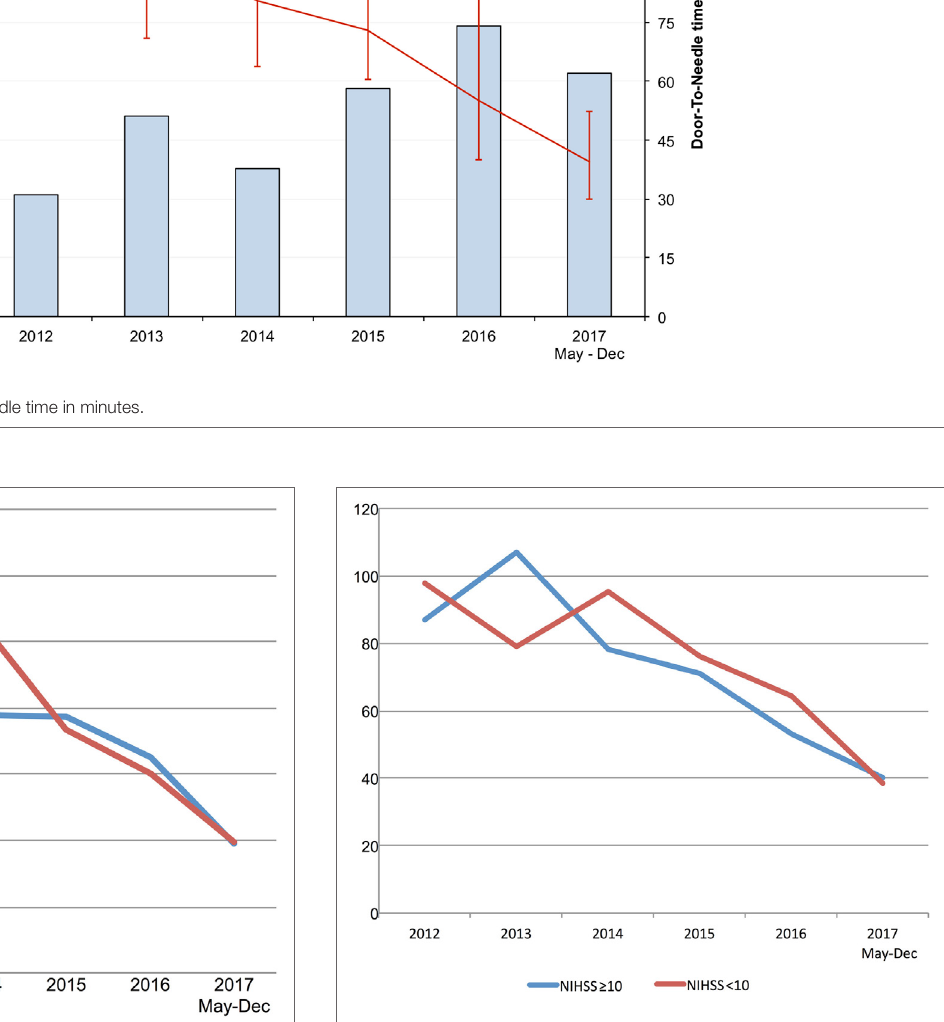
FigUre 4 | Stroke severity and treatment delays. Trends in door-to-needle time stratified by stroke severity. NIHSS, National Institutes of Stroke Scale Score. FigUre 3 | Multimodal imaging and treatment delays. Trends in door-to-